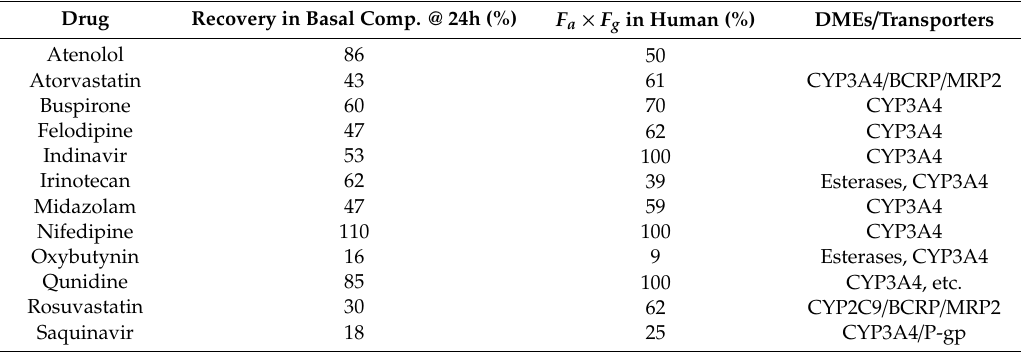
Table 6. Comparison of GI firstpass availability measured in EpiIntestinal microtissues and F a × F g in human. GI firstpass availability in EpiIntestinal microtissues was determined as described in 2.7. F a × F g in human for the tested drugs was calculated from the clinical pharmacokinetic data, as described in Section